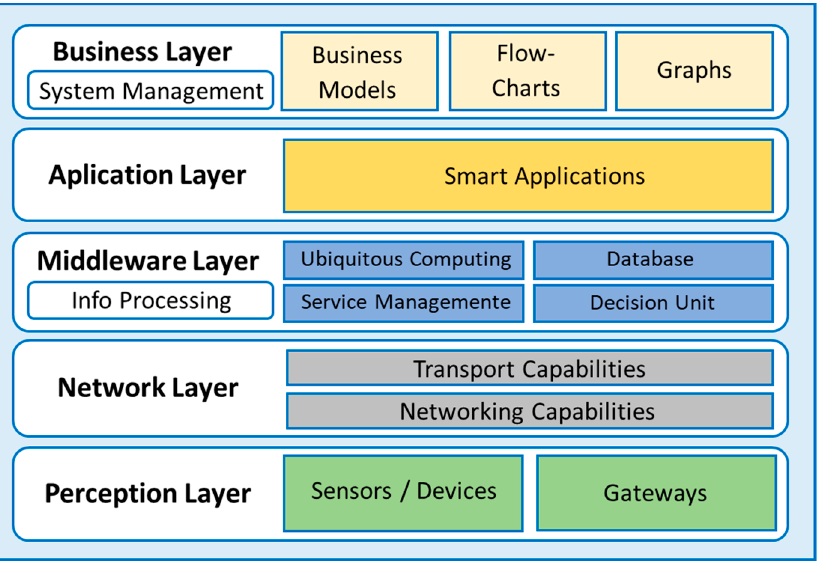
Figure 2. Layered architecture for waste management systems.